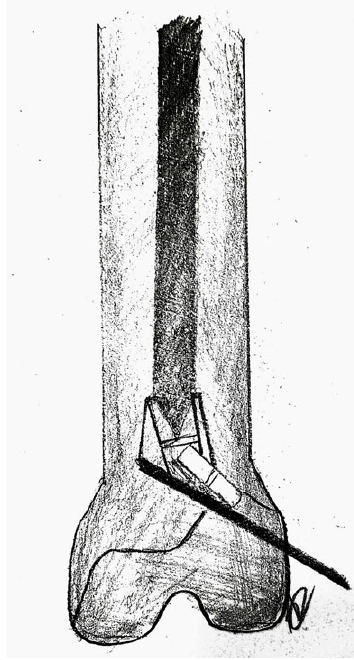
Figure 18. Tibial cortical windowing and retrograde levering.